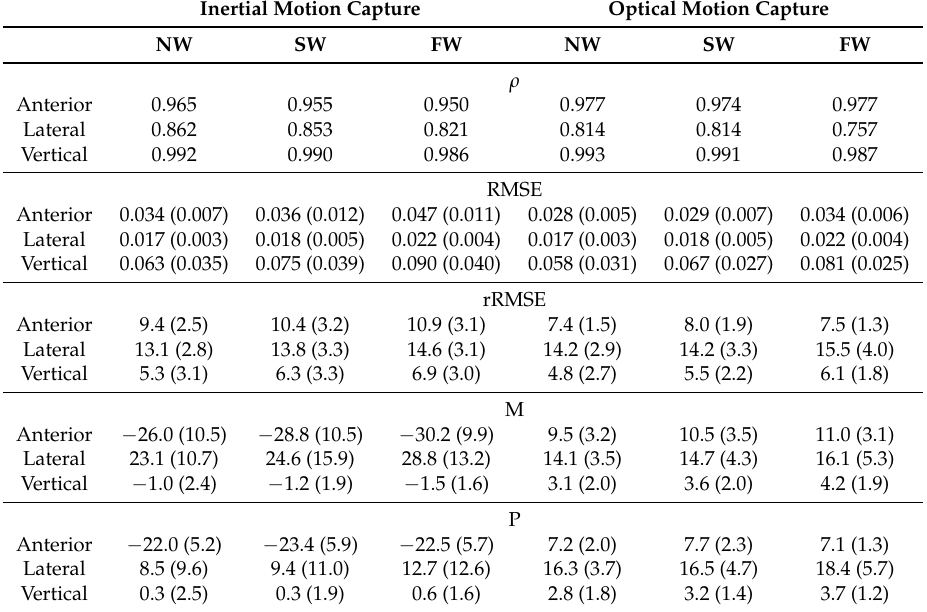
Table 3. Comparison of ground reaction forces (GRF) estimated from inertial motion capture and optical motion capture versus force plate measurements. ρ = Pearson’s correlation coefficient, RMSE = root mean square error in N/BW, rRMSE = relative root mean square error (%), M = curve magnitude difference (%) and P = phase difference (%). Results are analyzed during normal (NW), slow (SW) and fast walking (FW) for the decomposed right and left GRF.